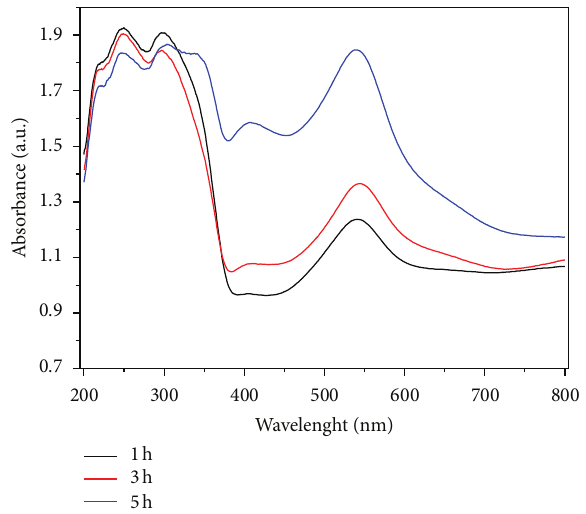
Figure 5: Absorption spectra of TNT arrays sensitized with N- 719 dye at various TNT-array lengths produced with 0.5wt% NH 4 F concentration, under simulated AM-1.5 solar illumination (100mWcm −2 ) and active area 0.28 cm 2 .